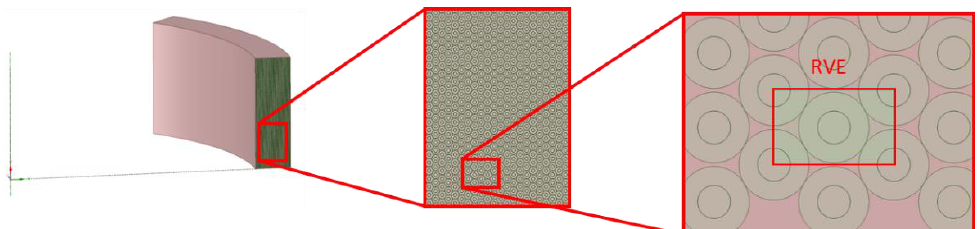
Figure 6. Selected representative volume element (RVE) cell from the global coil body.